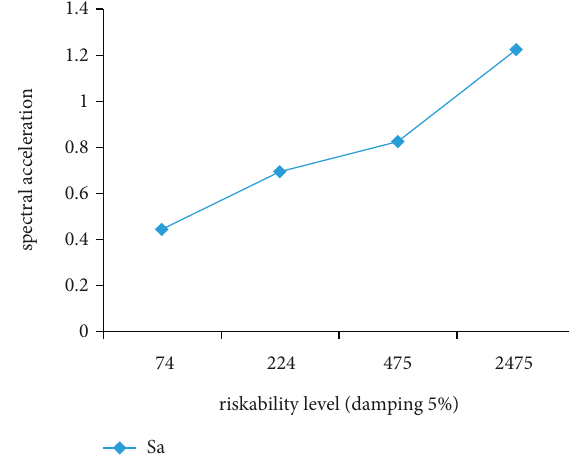
Figure 5: Seismic hazard curve of single-story cold-rolled steel structure with a period of